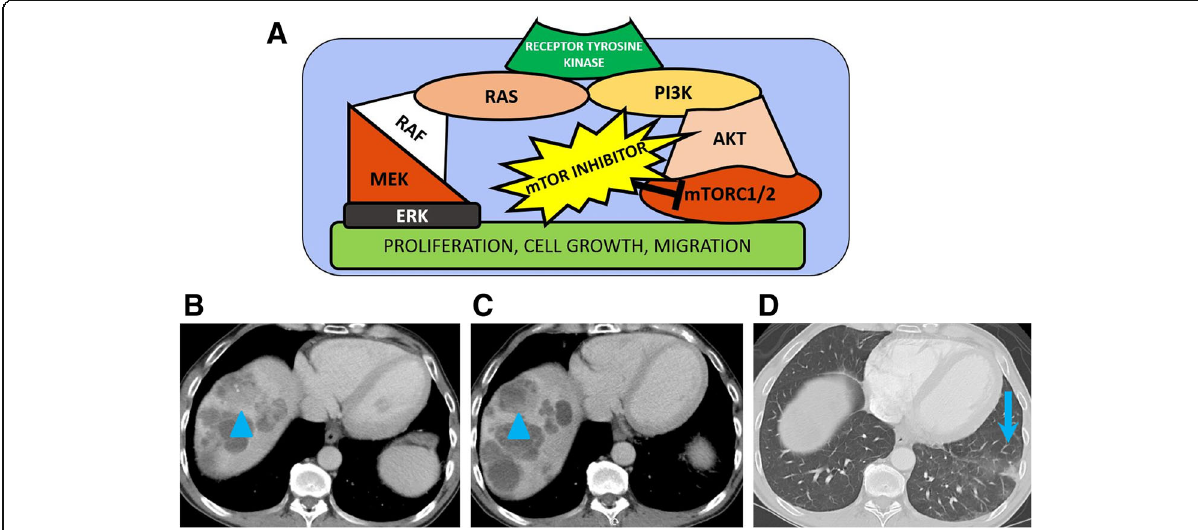
Fig. 5 PI3K pathway. a Image showing the PI3K-ATK-mTORC pathway and the blockage of the effector mTORC1/2 by the mTOR inhibitors, such as everolimus. b – d Baseline and restaging contrast-enhanced CT images of a 60-year-old man with metastatic neuroendocrine tumor on everolimus show decreased enhancing component of a liver metastasis (arrowheads), representing response to treatment. Patient developed drug induced pneumonitis while on treatment (arrow) ( d